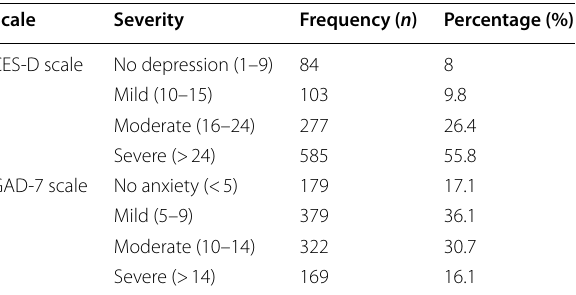
Table 2 Prevalence of anxiety and depression based on severity